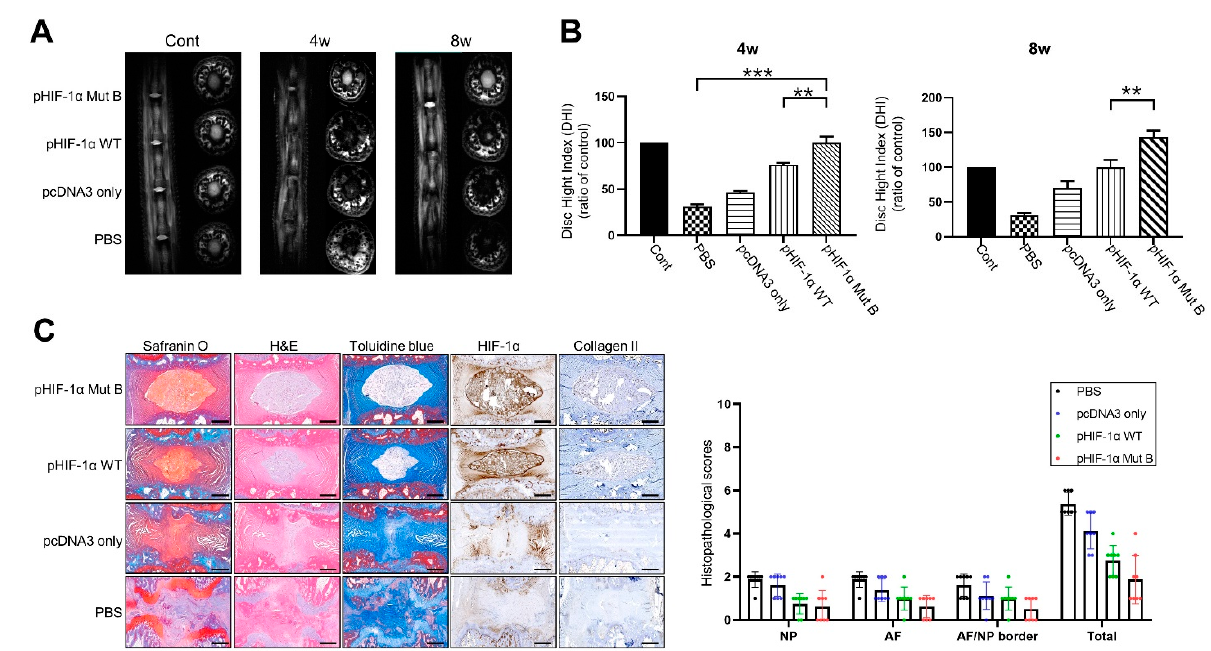
Figure 4. CA HIF-1 α (pHIF-1 α Mut B) ameliorates disc degeneration. ( A ) Representative T2 weighted micromagnetic resonance imaging (MRI) of rat tail in the four groups at 4 and 8 weeks. ( B ) Disc height index (DHI) of four groups at 4 and 8 weeks. ** p -value < 0.01, *** p -value < 0.005. ( C ) Histology and immunohistochemistry in puncture-induced rat IVD degeneration model. Histological analysis of intervertebral discs by Safranin O, H&E, Toluidine blue staining, and immunohistochemical staining of HIF-1 α and collagen II in the nucleus pulposus (NP) in all groups. Scale bars represent 100 µ m. ** p -value < 0.01, *** p -value < 0.005.